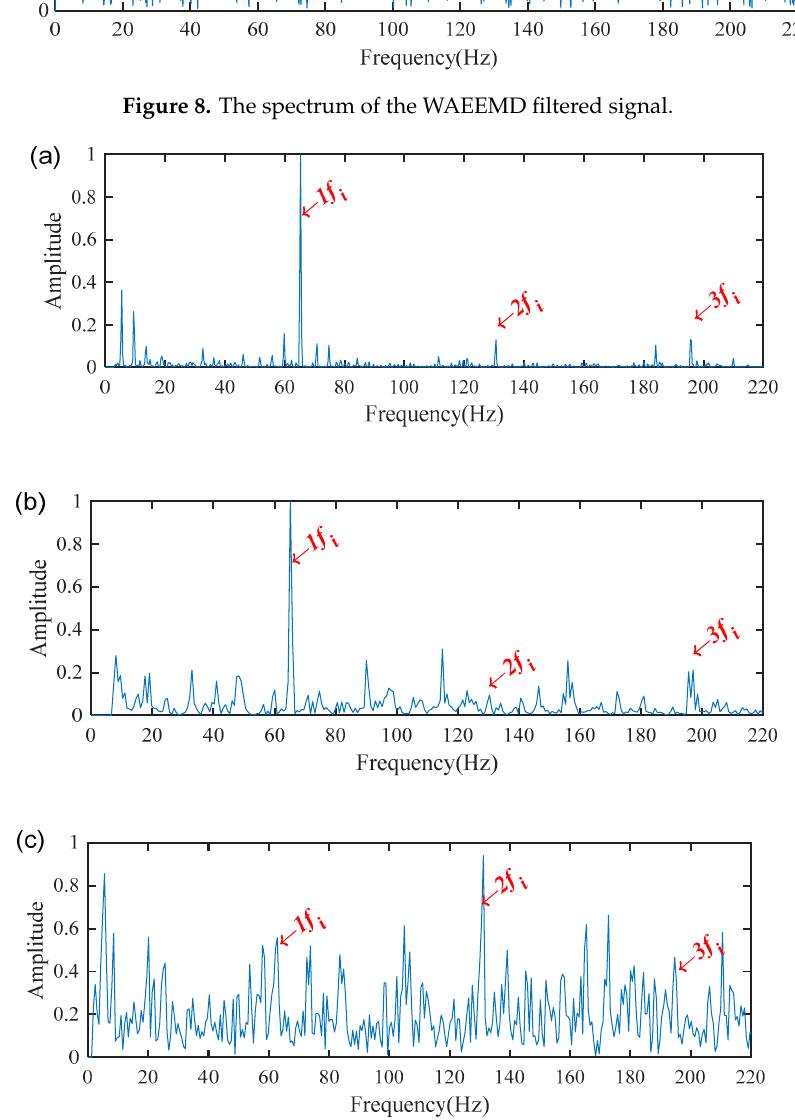
Figure 9. Diagnosis results for the bearing inner race fault using: ( a ) WAEEMD-MSB; ( b ) conventional MSB; ( c ) EEMD-MSB.